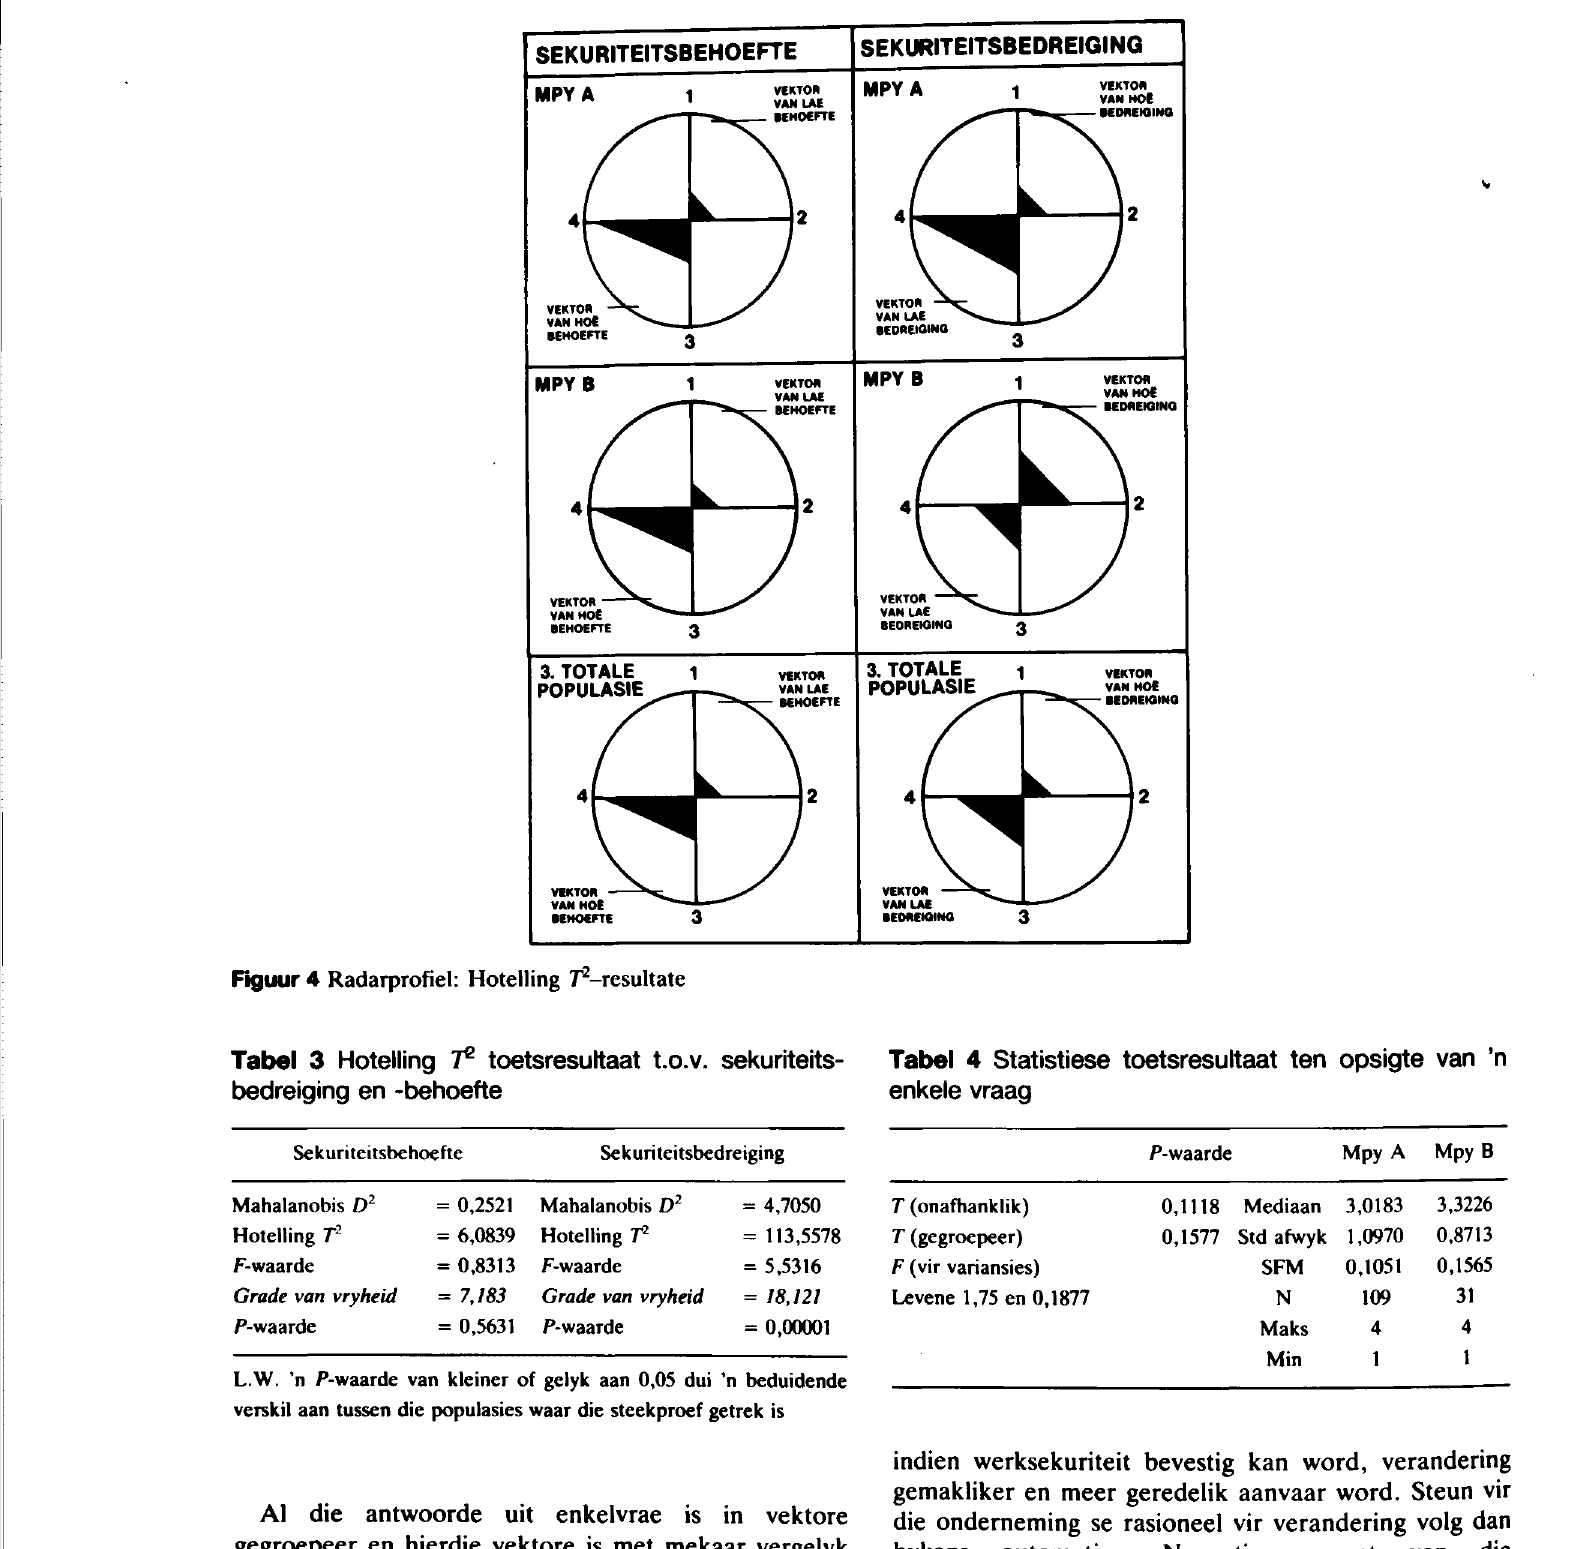
Tabel 4 Statistiese toetsresultaat ten opsigte van 'n enkele